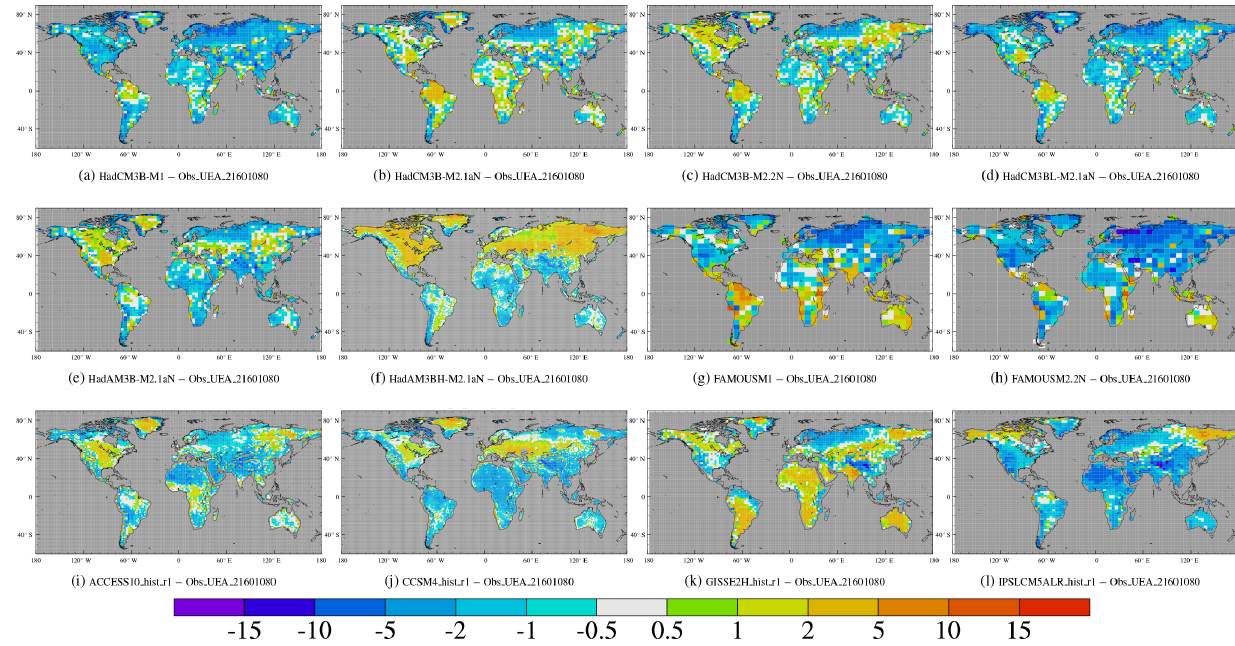
Figure 3. (a) The difference between the annual mean surface air temperature (in ◦ C) of HadCM3B-M1 and the CRU CL v2.0 for the period 1960–1990 regridded onto the HadCM3B-M1 grid, (b) As (a) for the HadCM3B-M2.1a version, (c) As (a) but for HadCM3B-M2.2, (d) As (a) but for the HadCM3BL-M2.1aN version, (e) As (a) but for HadAM3B-M2.1a, (f) As (a) but for HadAM3BH-M2.1a, (g) As (a) but for FAMOUS-M1, and (h) As (a) but for FAMOUS-M2.2. Panels (i, j, k, l) show comparable results for four CMIP5 models, ACCESS1-0, CCSM4, GISS-E2-H and IPSL-CM5A-LR respectively. These were chosen to represent two models which were above the CMIP5 average in terms of their RMSE with respect to surface air temperature, and two models which were below average. All differences are calculated by regridding the CRU data onto the corresponding model grid, using simple bi-linear